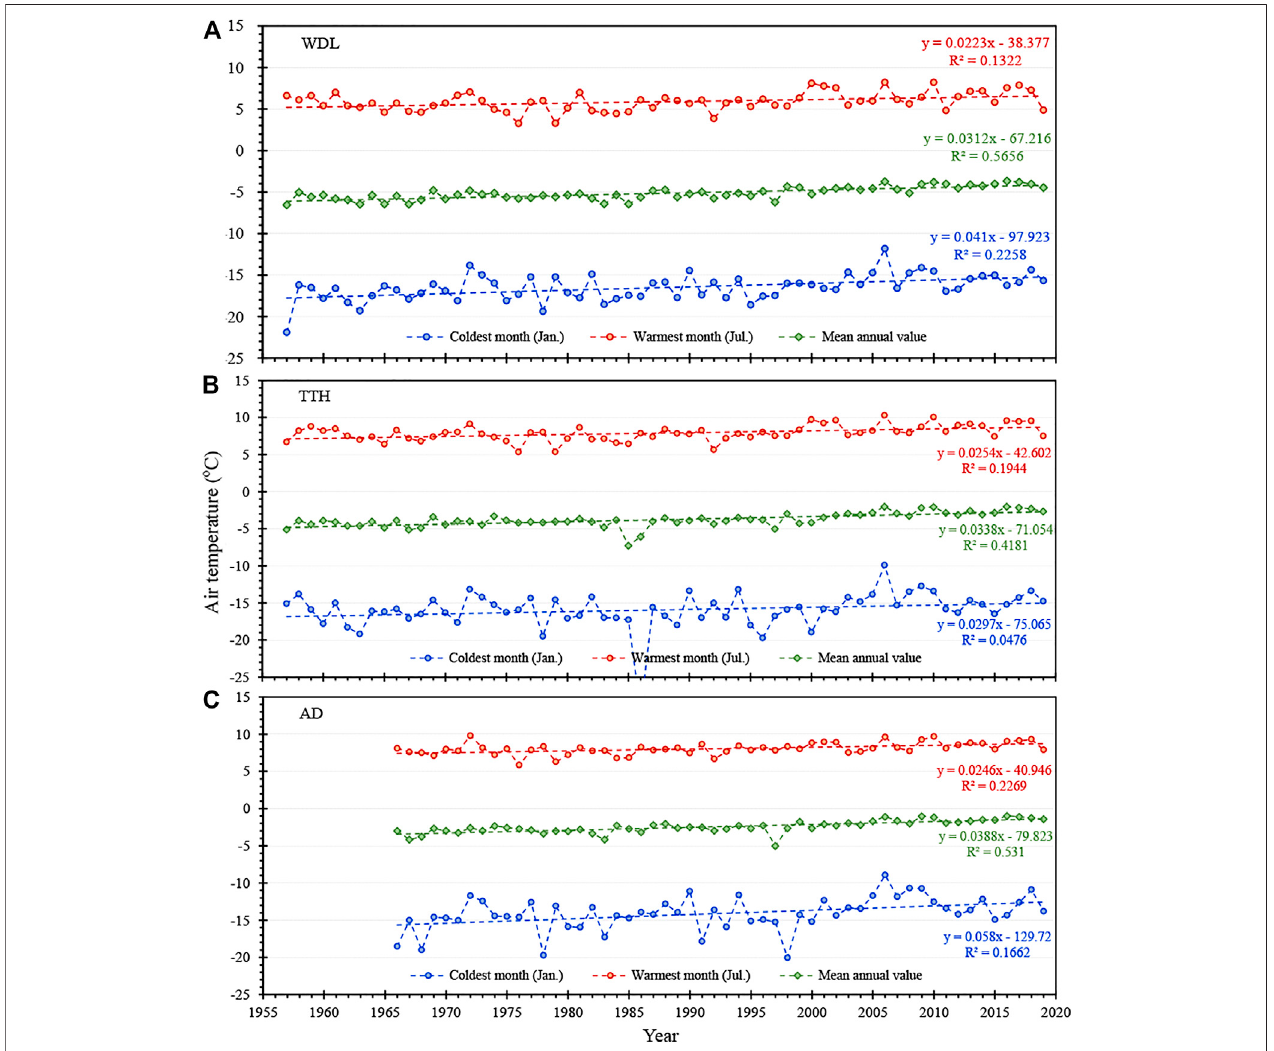
FIGURE 4 | Long-term records in annual mean, coldest month (January), and warmest month (July) air temperatures at three weather stations. (A) and (B) WDL and TTH (1957 – 2019), and (C) AD (1966 – 2019).